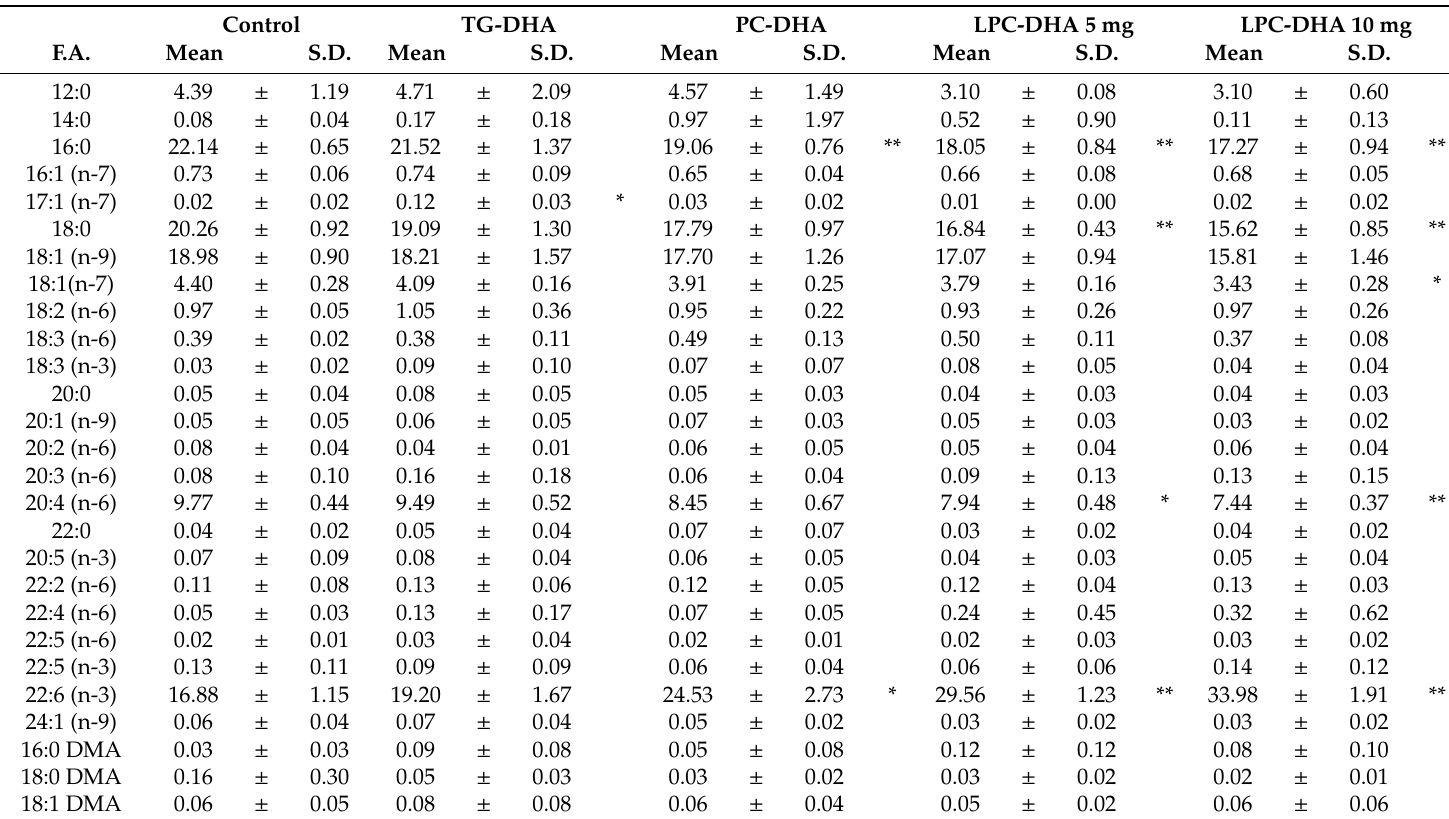
Table 1. E ff ect of dietary TG-DHA, di-DHA PC, and LPC-DHA on rat retinal fatty acid composition.